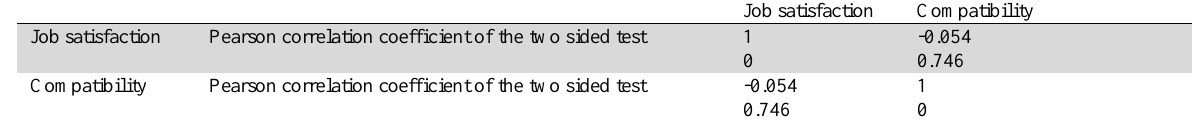
Job satisfaction Compatibility